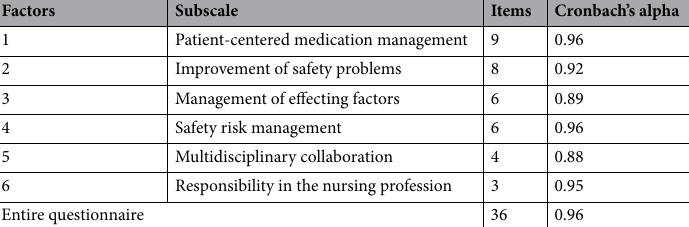
Table 3. Cronbach’s alpha of subscales and the entire medication safety competence scale